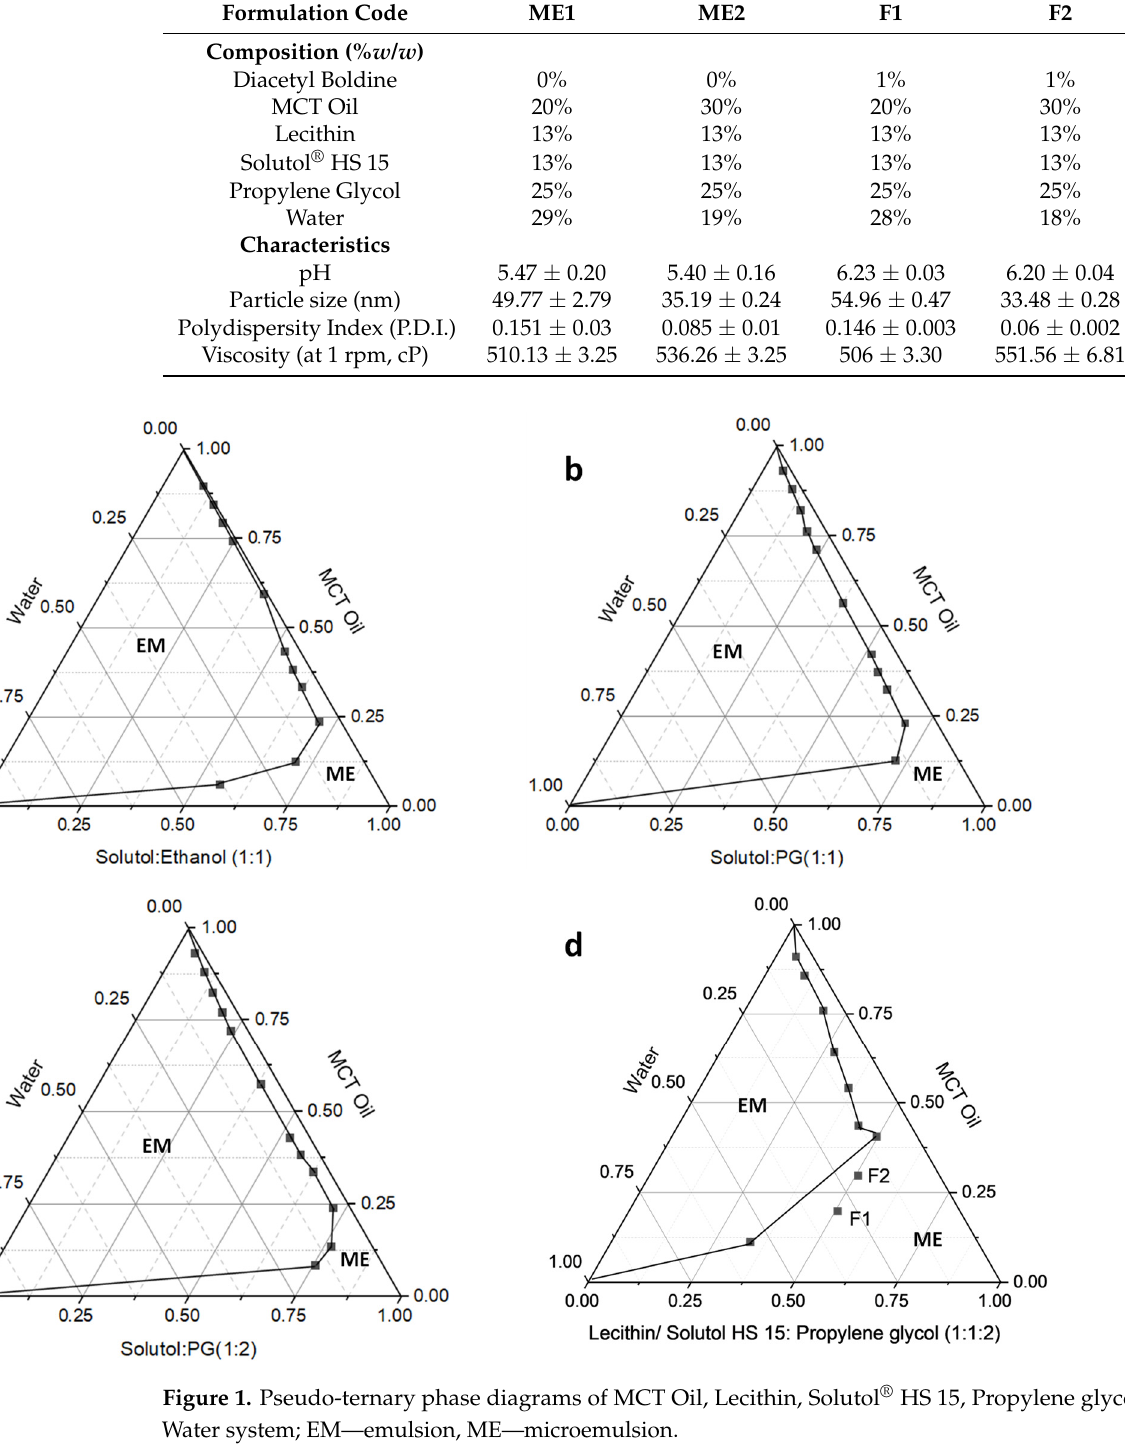
Table 1. Composition and characteristics of microemulsion formulations.